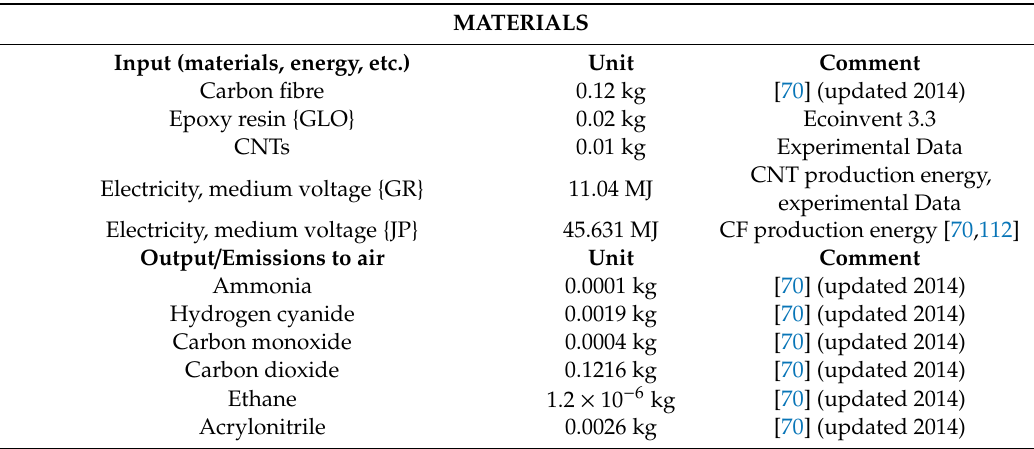
Table A1. Life cycle inventory (LCI) of 1-piece (0.15 kg) handbrake